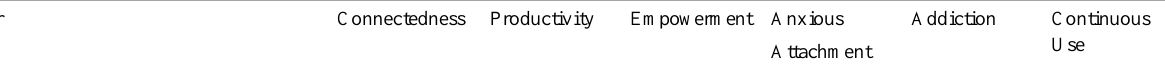
Table 2. Confirmatory factor analyses, item loadings, and Cronbach coefficient alpha for 6 correlated factors that were modeled using the whole sample.